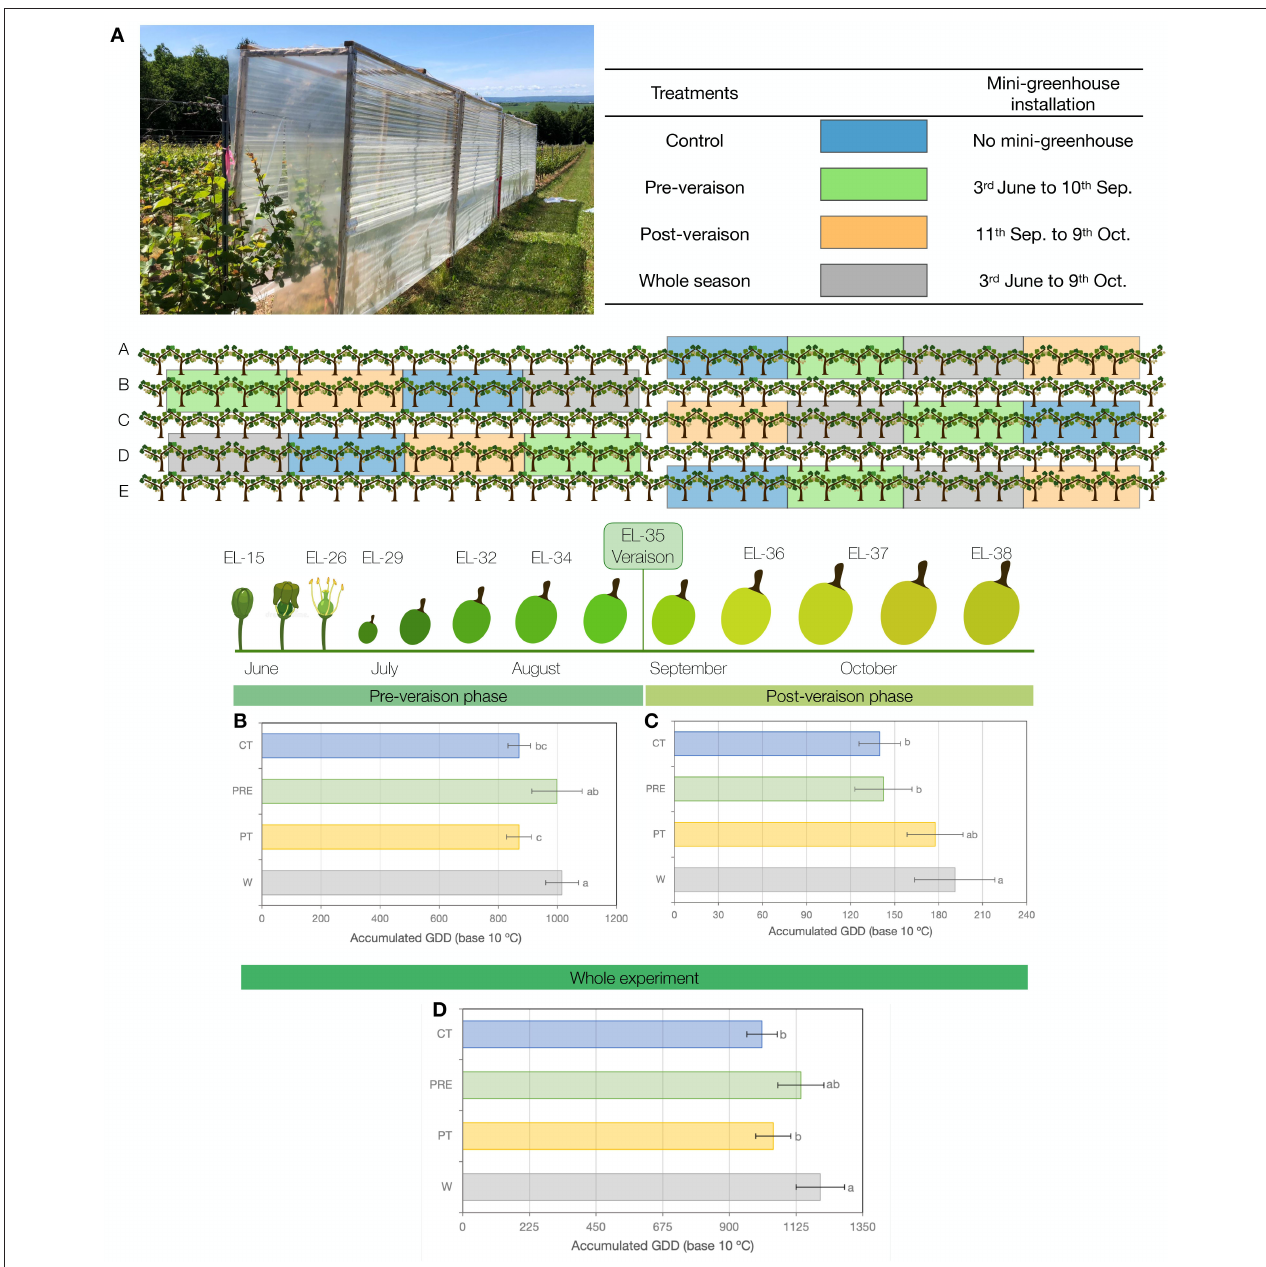
FIGURE 1 | (A) Mini-greenhouse, temperature treatments over the growing season, and experimental design. (B) Accumulation of growing degree days (GDD; based on 10 ◦ C) during the experiment. Pre-veraison phase (from 3 June 2020 to 10 September 2020). (C) Post-veraison phase (from 11 September 2020 to 9 October 2020). (D) Whole experiment (from 3 June 2020 to 9 October 2020). Values are means ± SD ( n = 5 for Whole, Pre, and PT; n = 3 for CT). For each graph, values with different letters indicate significant differences between treatments (Tukey’s test at p ≤ 0.05).